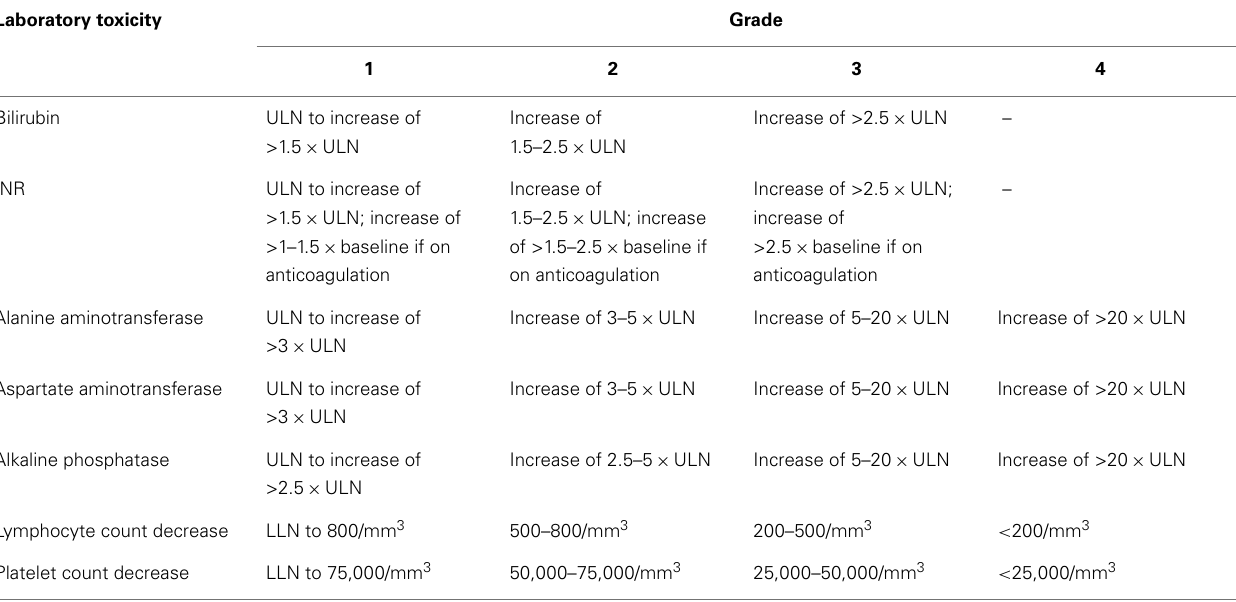
Table 4 | Some relevant laboratory toxicities according to the CTCAE v4.0